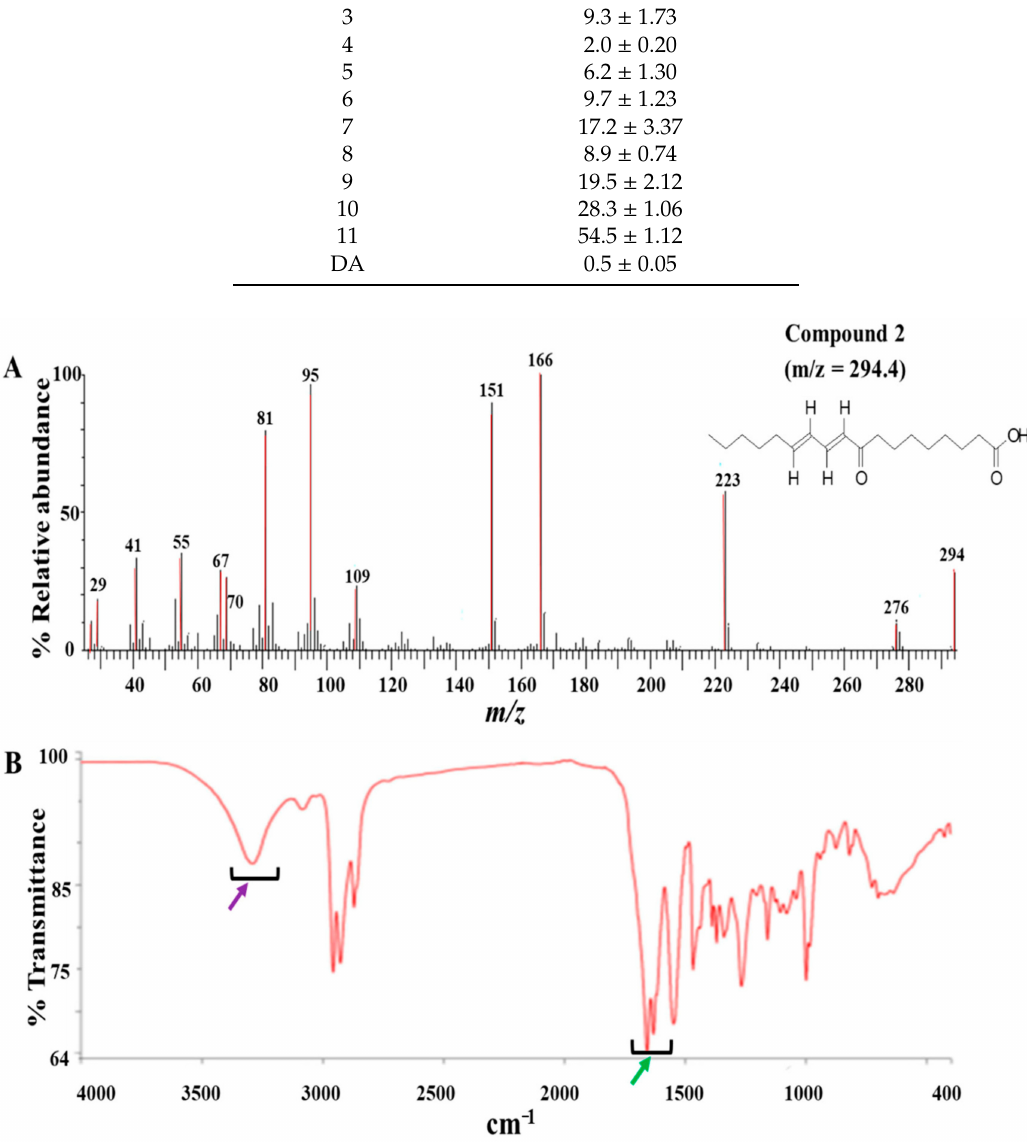
Figure 1. GC-MS and ATR-IR analysis of compound 2 : Compound 2 was isolated from the dichloromethane fraction of Z. zanthoxyloides (root) and identified through gas chromatography-mass spectrometric (GC-MS) analysis. The mass fragmentation of compound 2 identified it as 9-oxo-ODA with m / z = 294.40 ( A ). The IR spectrum displayed absorbance intensities within a range of wavenumbers suggestive of carboxyl (1760–1690 cm − 1 ) ( B , green arrow) and hydroxyl stretches (3500–3200 cm − 1 ) (( B ), purple